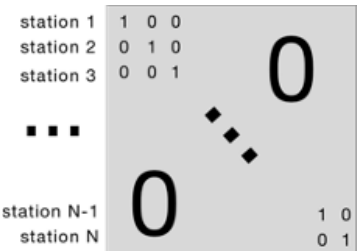
Figure C1. A diagrammatic explanation of the one-hot encoding vectors, where each station is given a unique encoding by using an identity matrix of size N (number of stations). Each gauging station is encoded by a vector of ones and zeros (a vector of length N